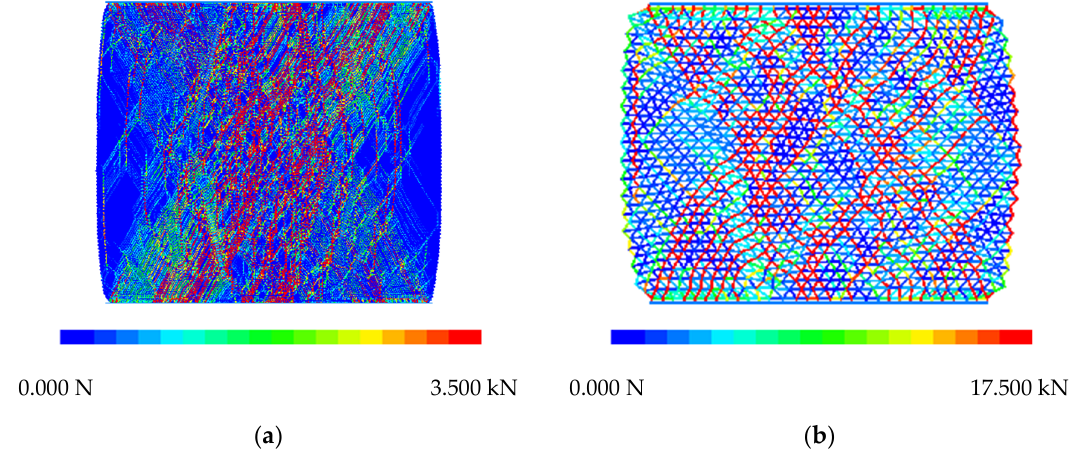
Figure 4. Contact force cloud diagram of concrete specimen. ( a ) 1 mm particle size. ( b ) 5 mm particle size.